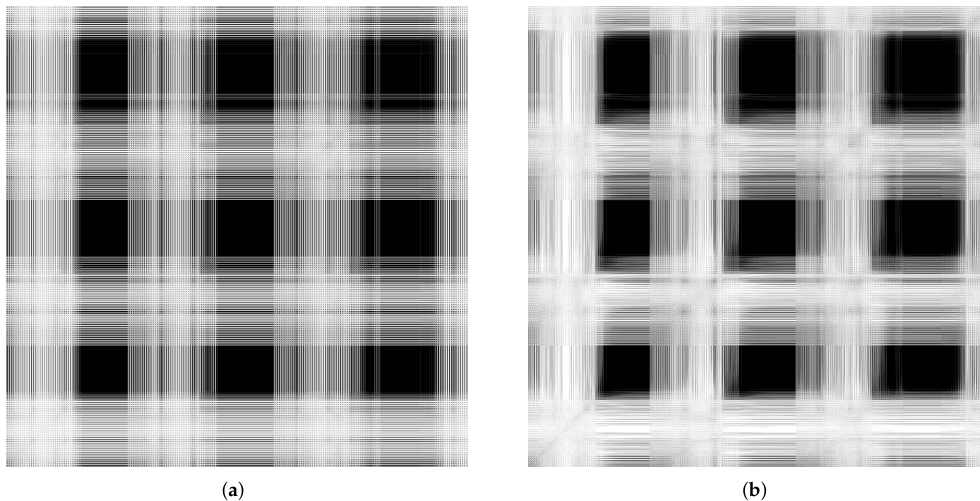
Figure 10. Recurrence plots using MSRA3D dataset and setting optimal S R at 0.99 and I S at 0.1. ( a ) Self-organizing reservoir with RQA metrics: L MAX = 7601, LAM = 0.999905, DET = 0.999976, RR = 0.999052; ( b ) Randomly initialized reservoir with RQA metrics: L MAX = 4419, LAM = 0.989145, DET = 0.985305, RR = 0.931044.